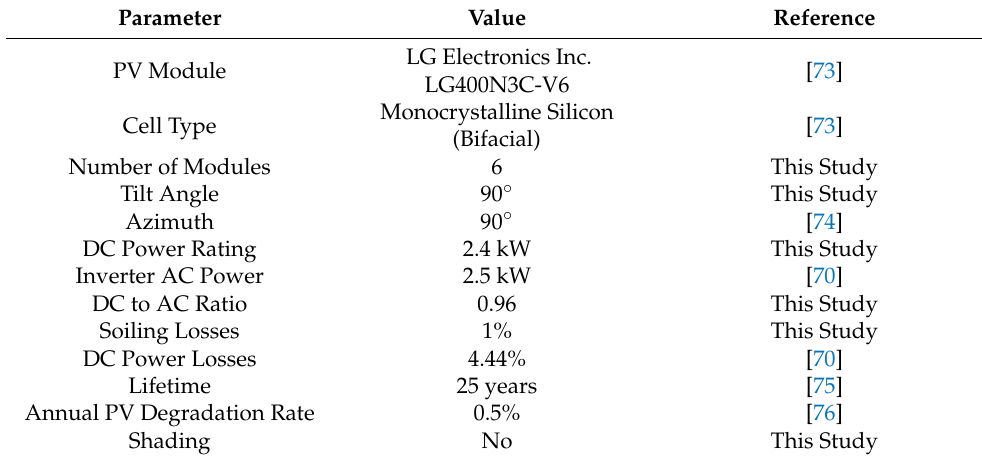
Table 2. Parameters used in the energy performance simulation of vertical bifacial